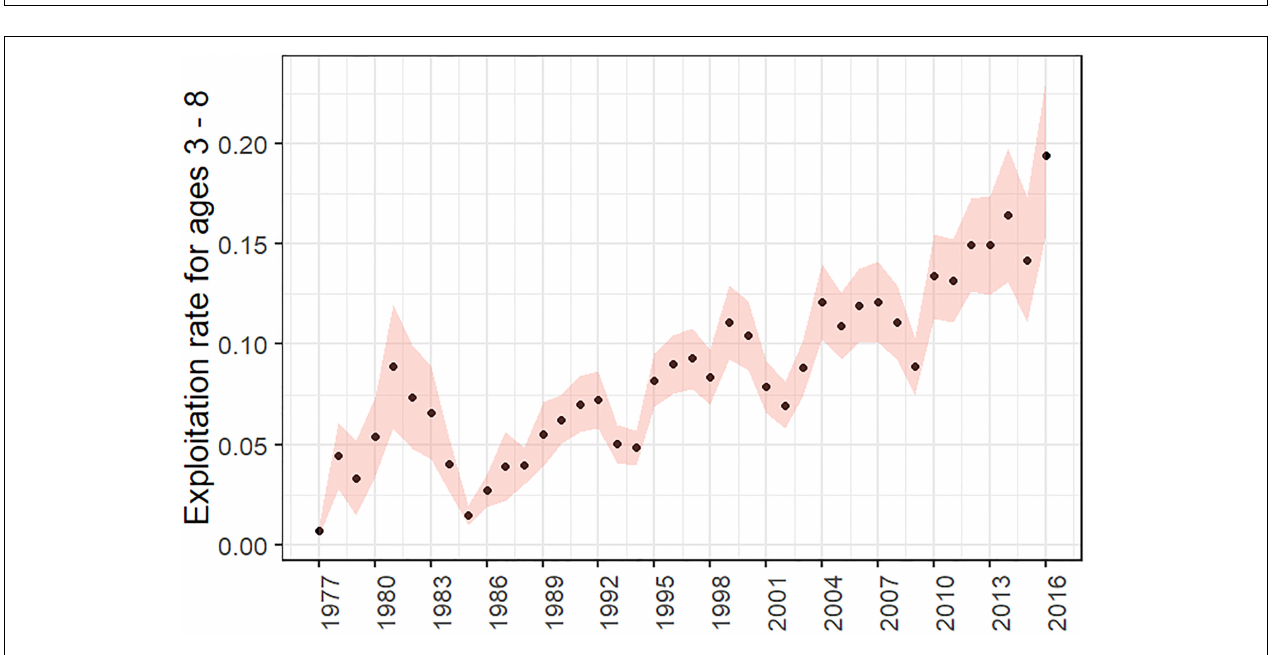
FIGURE 6 | (A) Numbers (1 × 10 9 ) of Pacific cod from the Alaska Fisheries Science Center (AFSC) bottom trawl survey, (B) relative population numbers (RPNs 1 × 10 5 ) from the AFSC longline survey, (C) RPNs (1 × 10 4 ) from the International Pacific Halibut Commission (IPHC) longline survey, and (D) relative biomass from the Alaska Department of Fish and Game (ADF&G) bottom trawl survey with shaded 95% confidence intervals.